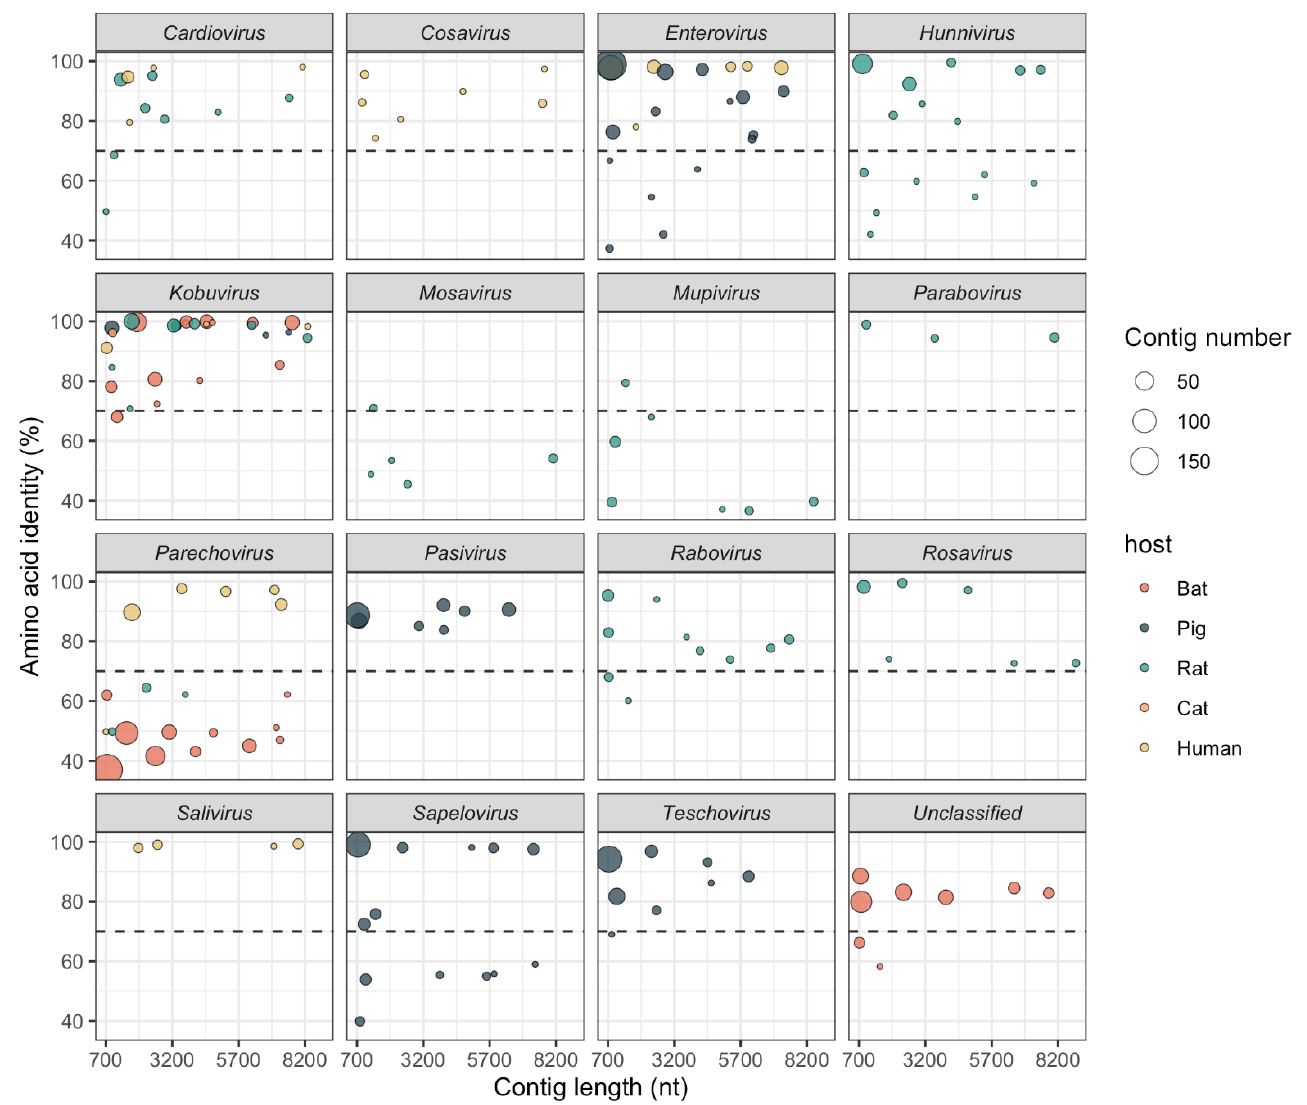
Figure 3. Identity of contigs to the closest related sequence in NCBI. Circle size indicates the number of contigs, and fill colour indicates the host. Contigs with <70% aa identity to reference sequences (dotted line) may represent members of novel species.